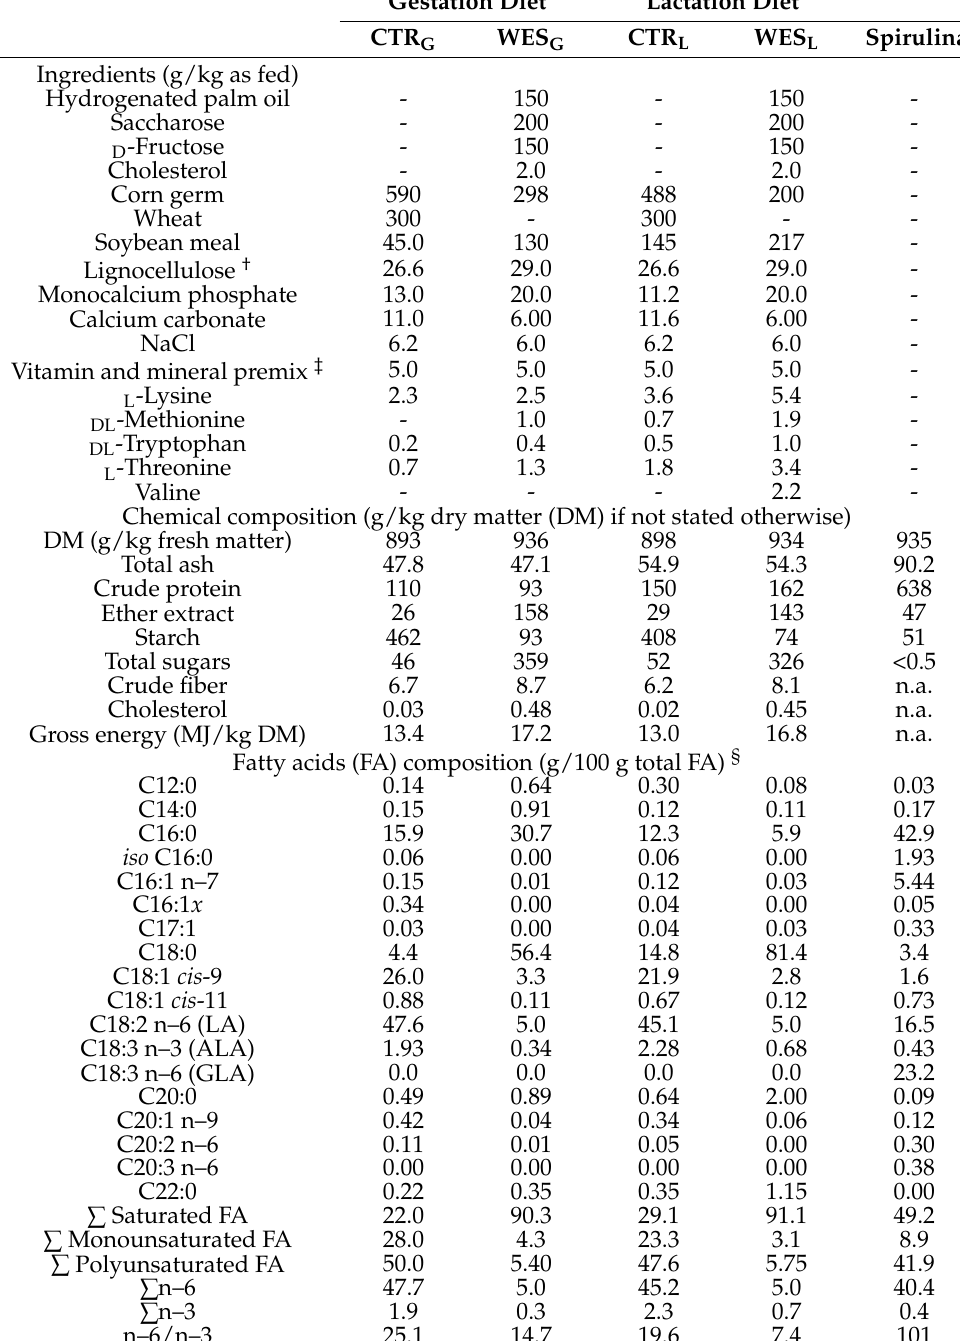
Table 1. Ingredients and composition of experimental